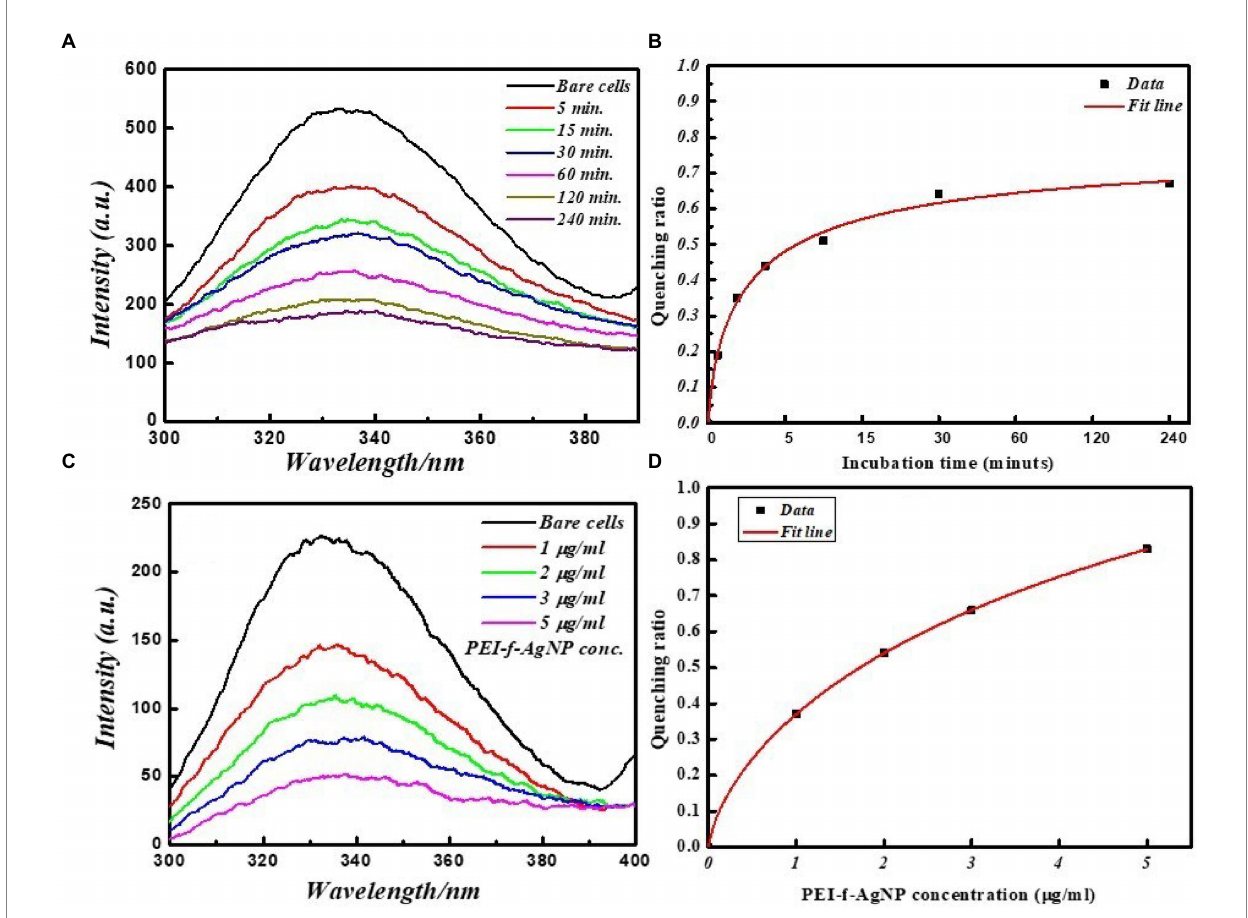
FIGURE 4 FL emission spectra of C. albicans cell surface proteins at various incubation times with and without PEI-f-Ag-NPs. (A) 2D fluorescence emission spectrum, (B) FL quenching ratio by PEI-f-Ag-NPs at various incubation times, (C) FL emission spectra of C. albicans cell surface proteins with increasing concentration of PEI-f-Ag-NPs, and (D) FL quenching ratio with an increasing PEI-f-Ag-NPs